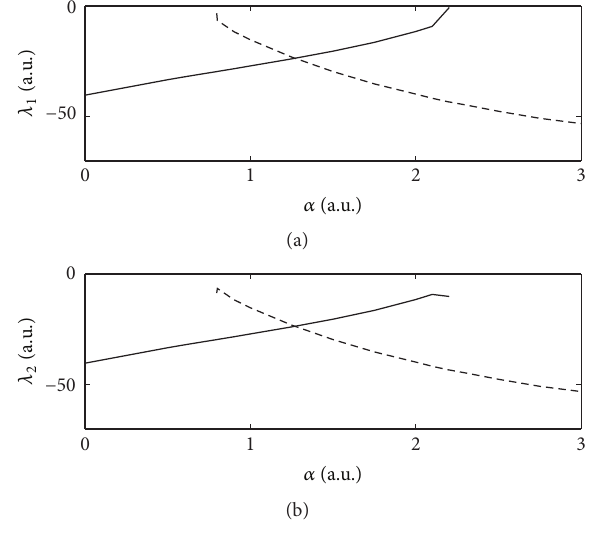
Figure 9: Eigenvalues 𝜆 1 (a) and 𝜆 2 (b) computed from (3), (4), and (22) for the state 𝑥 (low), 𝑦 (high) (solid lines) and the state 𝑥 (high), 𝑦 (low) (dashed line) shown in Figure 5 as functions of 𝛼 . Magnifying (not shown) the top parts of the two panels reveals that 𝜆 1 converges to zero when approaching the saddle-node bifurcation points, whereas 𝜆 2 assumes a finite negative value. Parameters: 𝐵 = 𝐷 = 1 ; all other parameters are as in Figure 5.